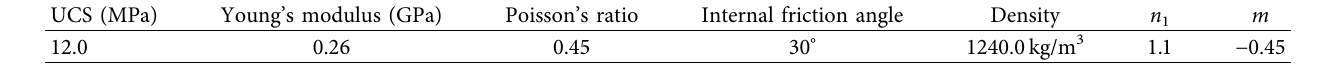
Table 9: The calculated total drilling cutting weight under different stress. σ v (MPa)